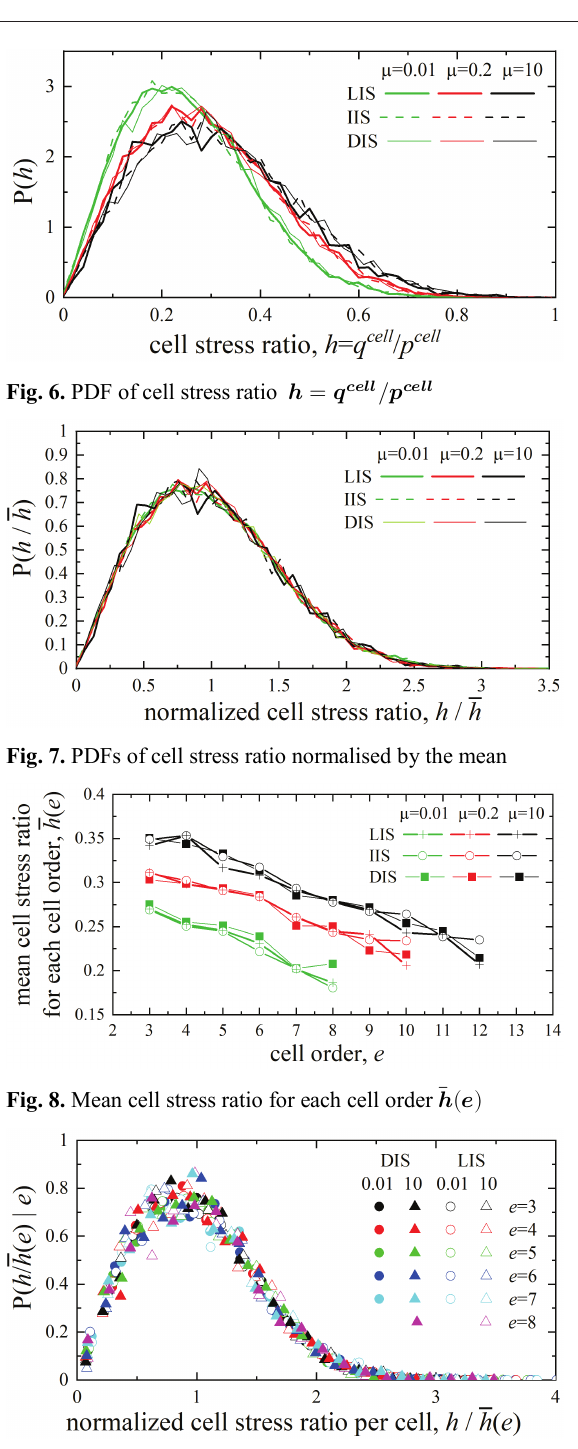
Fig. 9. PDFs of normalised cell stress ratio per